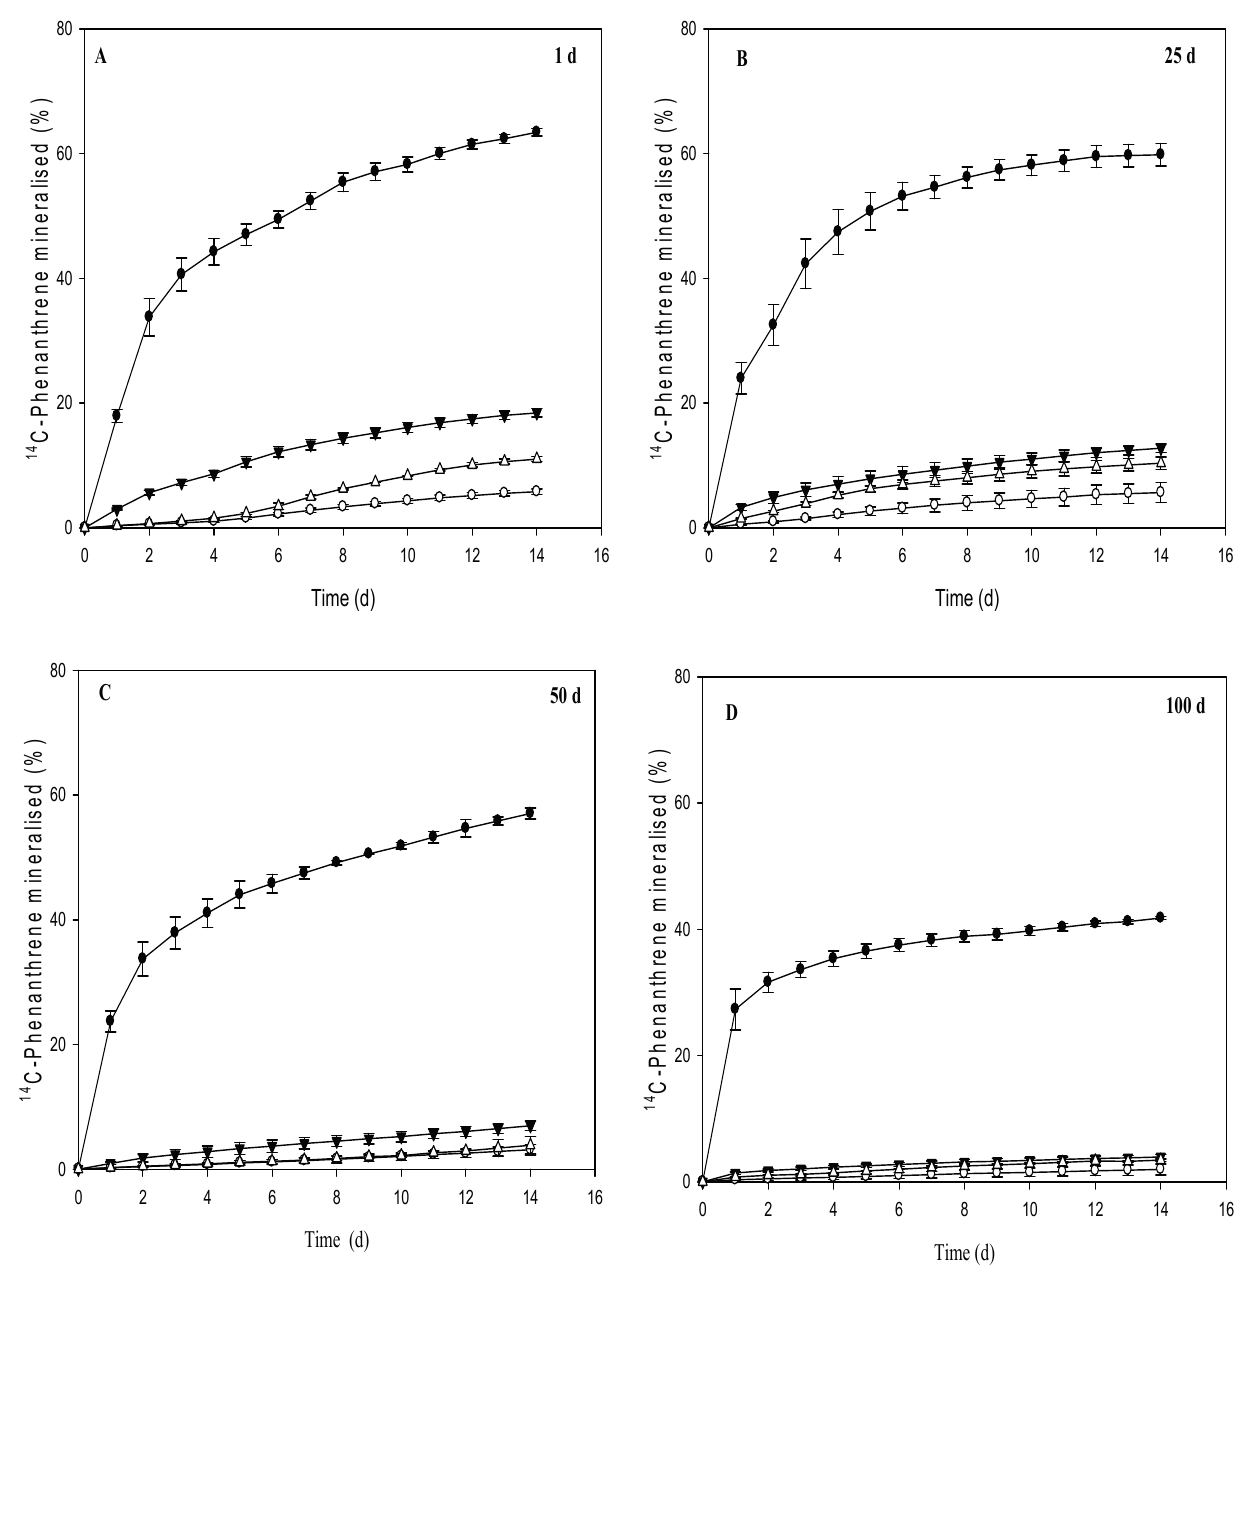
Figure 2. 14 C-Phenanthrene mineralisation by enriched inoculum in sterile Myerscough soil after AC addition at contact time: ( A ) 1 d ( B ) 25 d ( C ) 50 d ( D ) 100 d. Error bars are SEM ( n = 3). Legend key: 0% ( ● ), 1% CP1 ( ○ ), 1% CB4 ( ▼ ) and 1% AQ5000 ( ∆